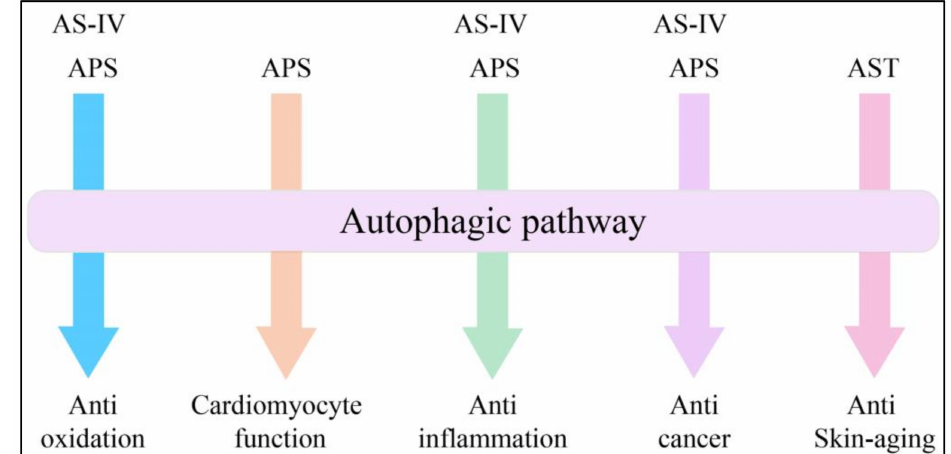
Figure 2. The pathological conditions where autophagy was shown to be involved in AM e ff ects. AM extracts show expanding e ff ects on autophagy dysregulation-associated diseases. AS-IV and APS both have e ff ects on oxidation, inflammation and cancer through regulation of autophagy. APS could also play a protective role in DOX-induced cardiotoxicity, while AST exerts antagonistic e ff ect on UVB-induced